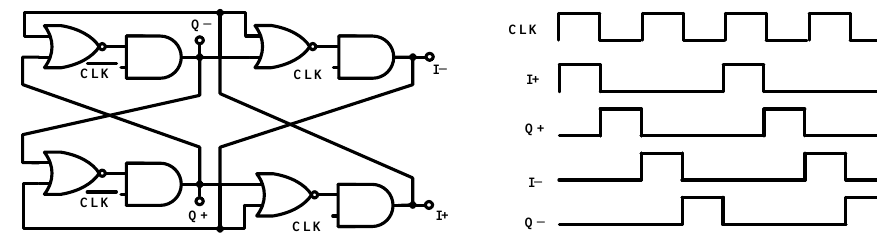
Figure 7. Generation of 25% duty-cycle quadrature